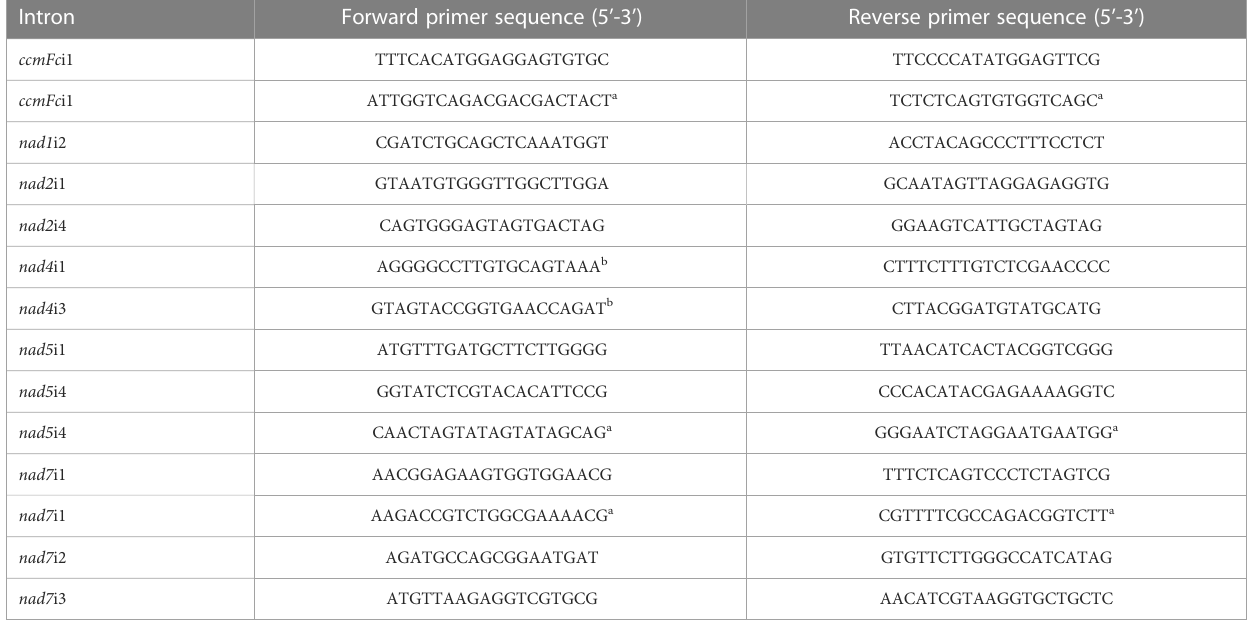
TABLE 2 Primers for ampli fi cation and sequencing of plant mitochondrial